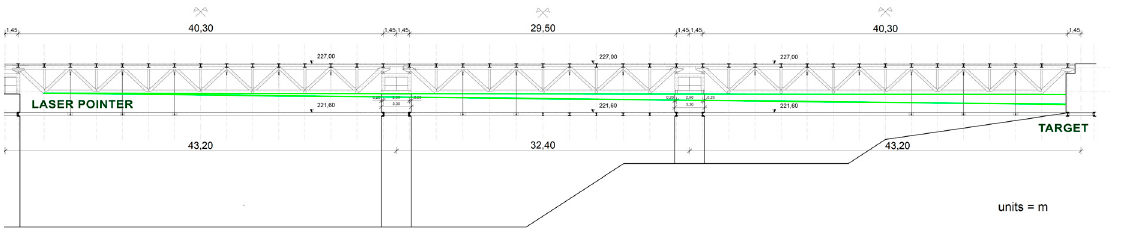
Figure 4. Cross section of the double-deck bridge at the University of Calabria.